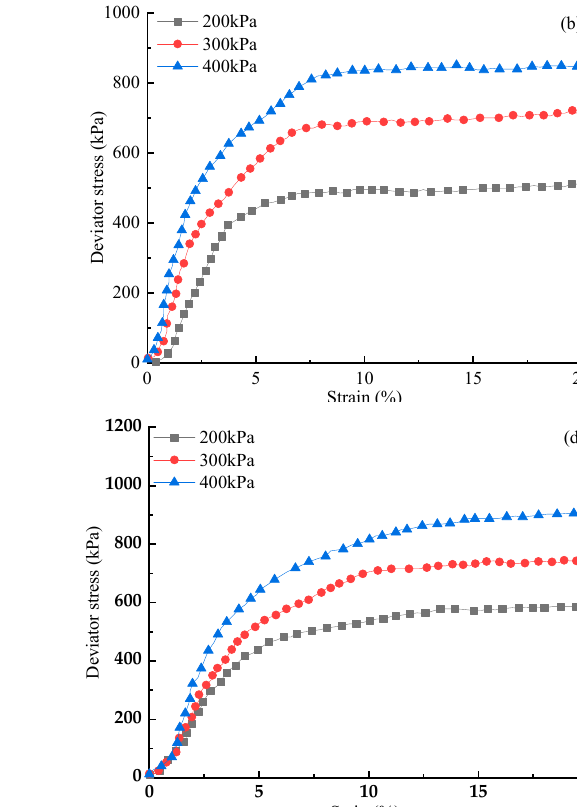
Figure 5 appears the stress-strain curve of unreinforced specimens and FAS speci- mens reinforced by PP fiber. reinforced by PP fiber. mens reinforced by PP fiber.